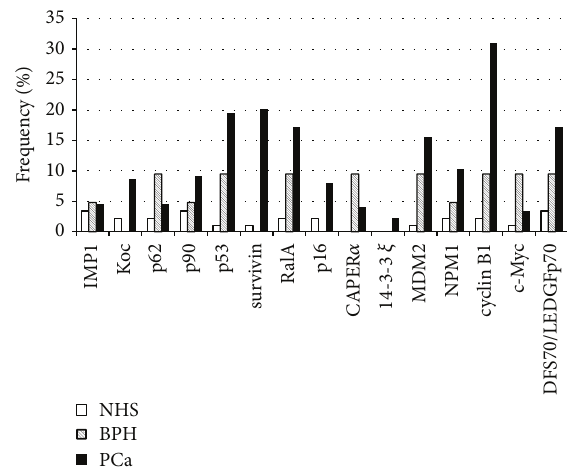
Figure 3: Percentage of autoantibody responses to a panel of 15 TAAs. The percentages refer to antibody titers exceeding the mean + 3SD of normal human sera from ELISA. In this panel of 15 TAAs, the highest reactivity antigen was cyclin